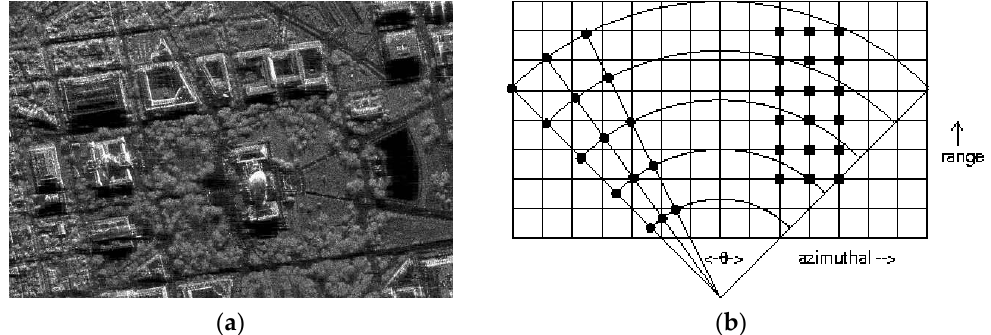
Figure 2. SAR Imagery and scene geometry ( a ) SAR image processing (Purdue), ( b ) SAR image processing (sandia.gov, accessed on 20 October